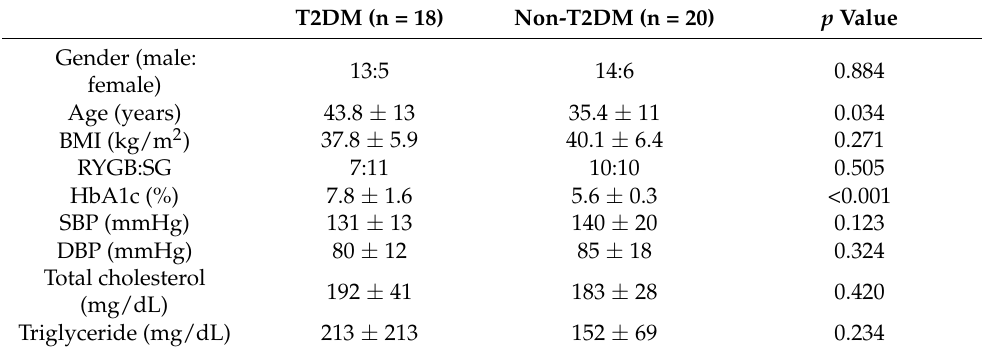
Table 1. Baseline characteristics of patients with type 2 diabetes mellitus (T2DM) and